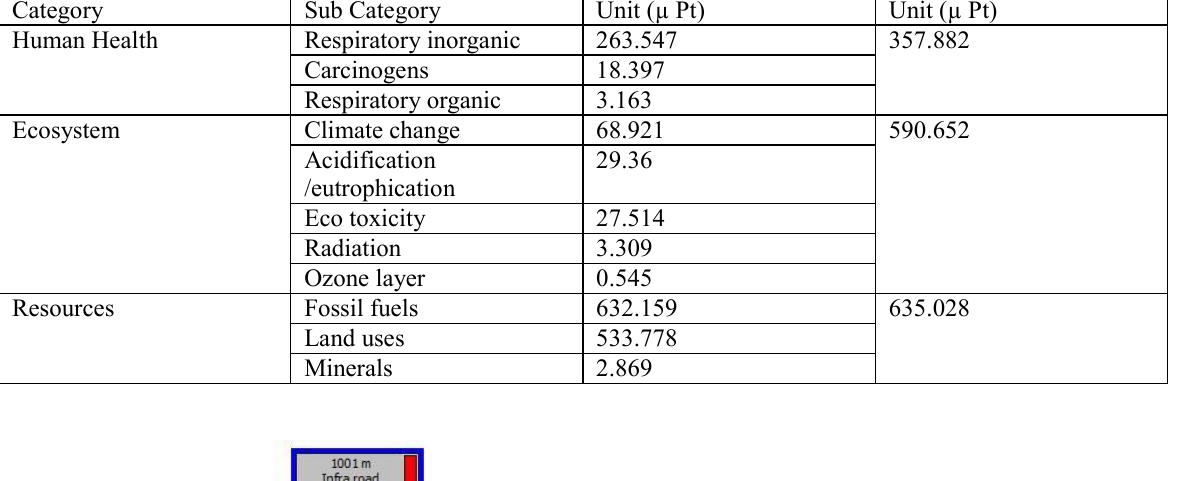
Weighting analysis of the categories.